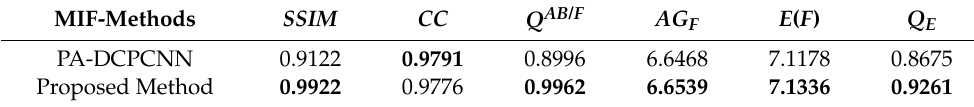
Figure 13. Multi-focus image of a lab from various perspectives. Original Image: ( a ), Multi-focus Input Images: ( b , c ), and Proposed Fusion: ( d ). Table 7. The results and comparisons for lab image